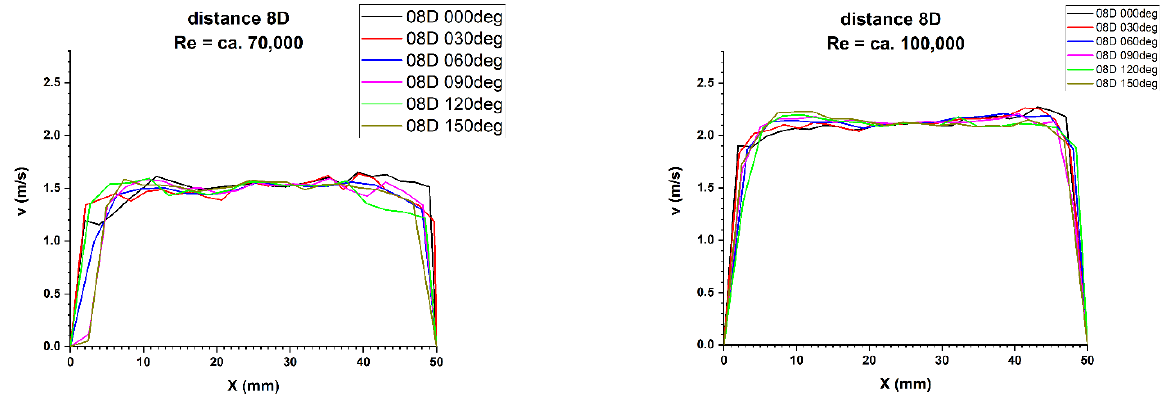
Figure 18. Comparison of projections on the velocity blocks the distances 10D from the disturbance with marked cross- sections for Re ≅ 70,000 and 100,000.